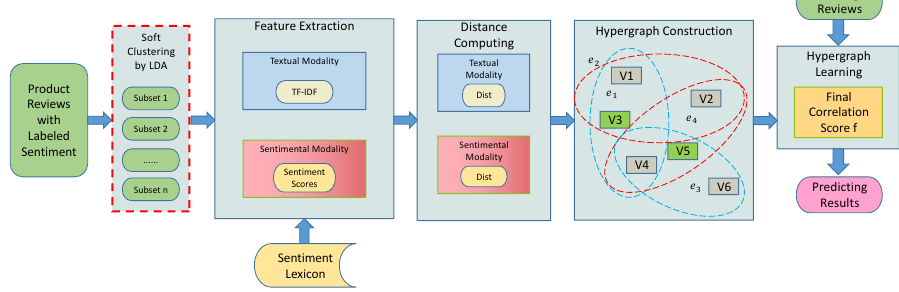
Figure 8. Schematic diagram of emotion classifier across modal hypergraphs [75].